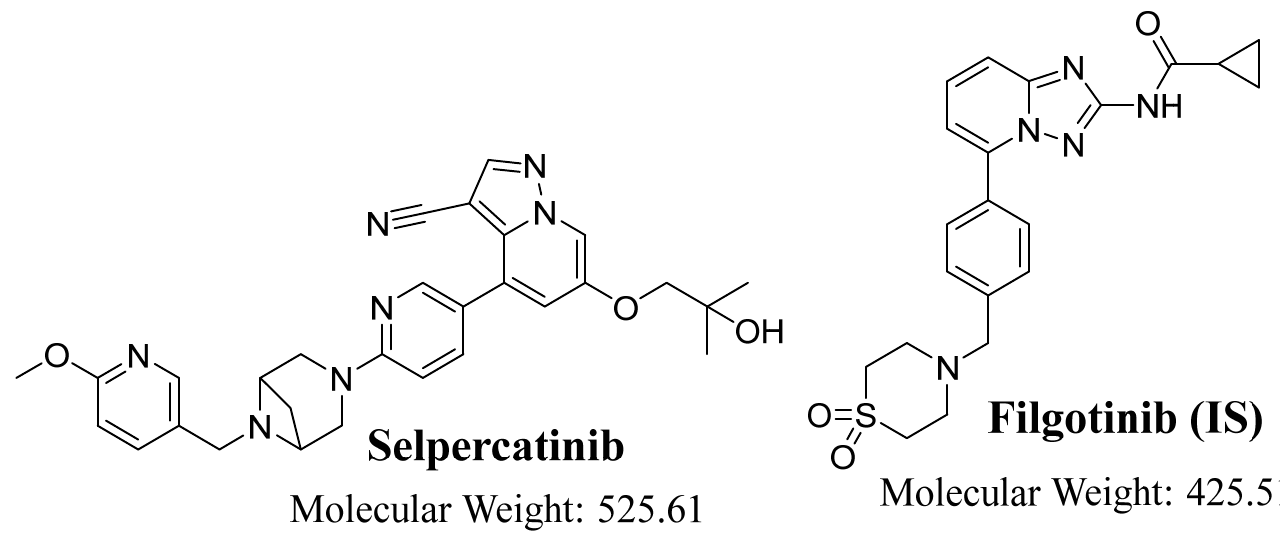
Figure 1. Chemical structures of selpercatinib and filgotinib (internal standard; IS).